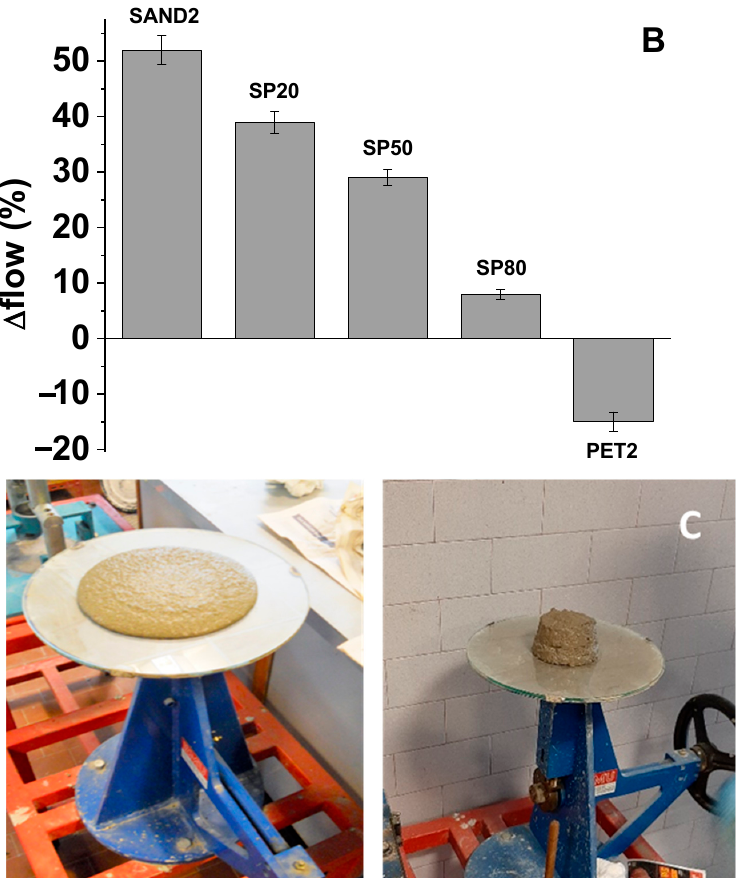
Figure 2. ( A ) Flows of the SAND and PET composites respective to the normalized mortar, ( B ) flows of the SP, SAND2 and PET2 composites respective to the normalized mortar, ( C ) flow tests of the SAND1 (left) and of the PET1 samples (right).